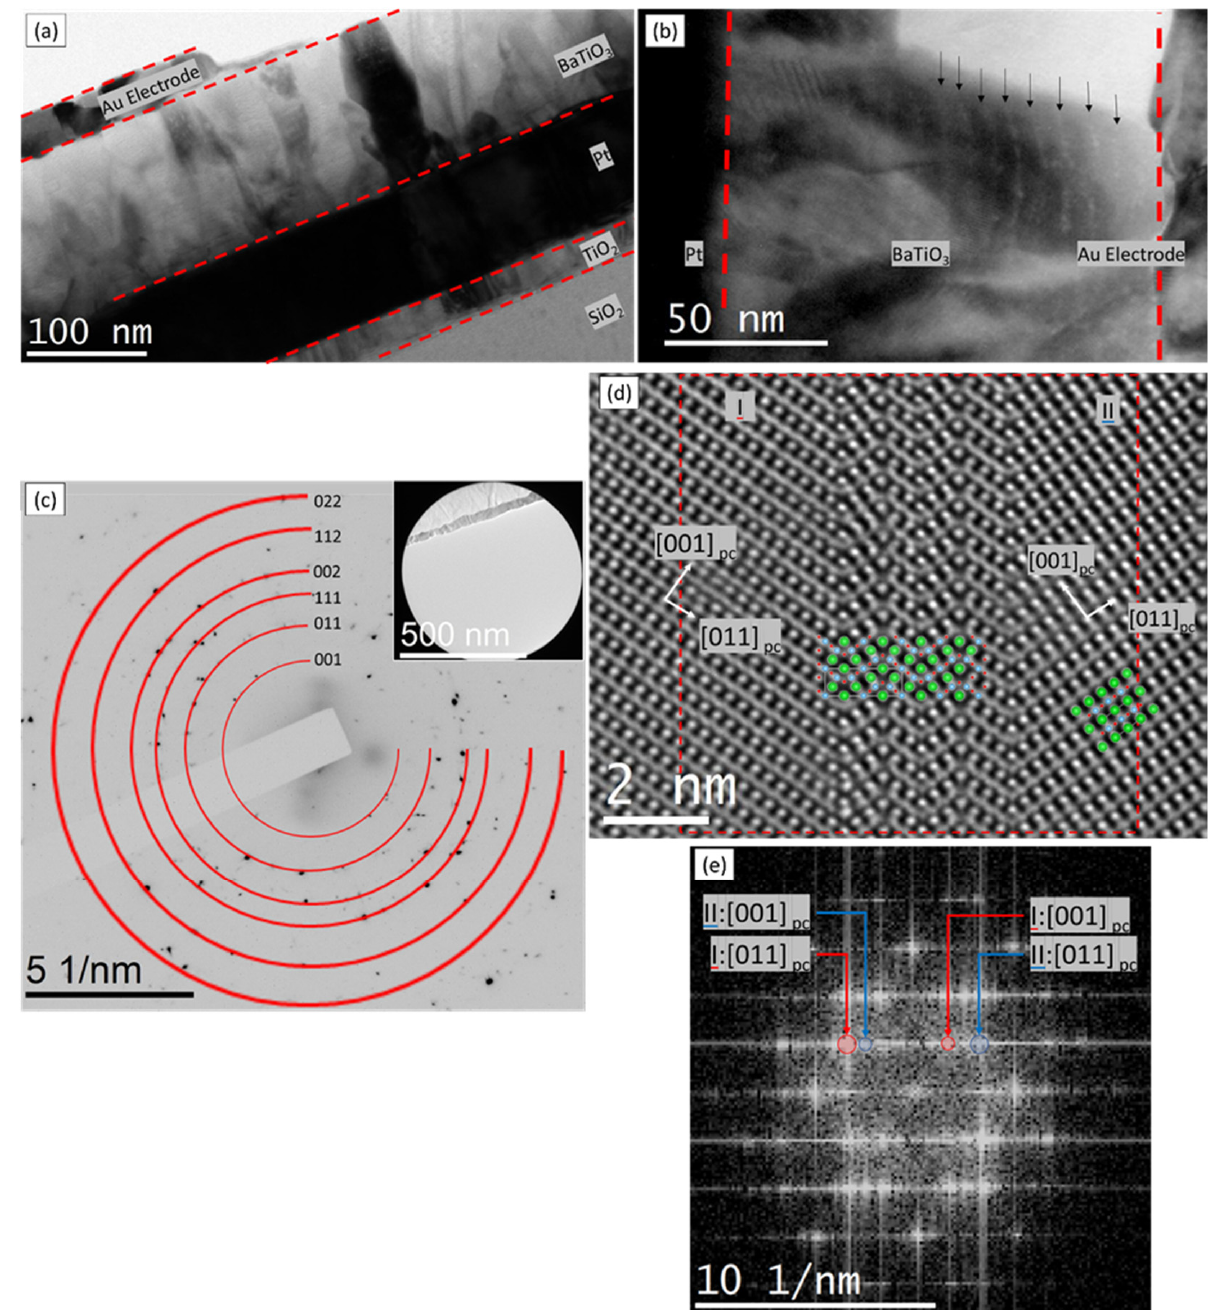
Figure 3. TEM analysis on a BaTiO 3 thin film sample prepared by wedge polishing followed by PIPS. ( a ) Brightfield (BF) image depicting the general film layout, showing also the different substrate layers. ( b ) BF image of an individual grain in the film, indicating that they are columnar; the deposition layers are also evident, their separation marked with black arrows. ( c ) SADP of the film, with red circles marking the expected positions of diffraction peaks for the BaTiO 3 cubic structure. The inset shows the area selected used to take the pattern. ( d ) HRTEM of a grain with a [110] zone axis orientation, presenting two variants separated by a hexagonal phase. Two illustrations of the hexagonal and cubic BaTiO 3 patterns are overlaid to confirm the structure. ( e ) FFT of the red square shown on ( d ).